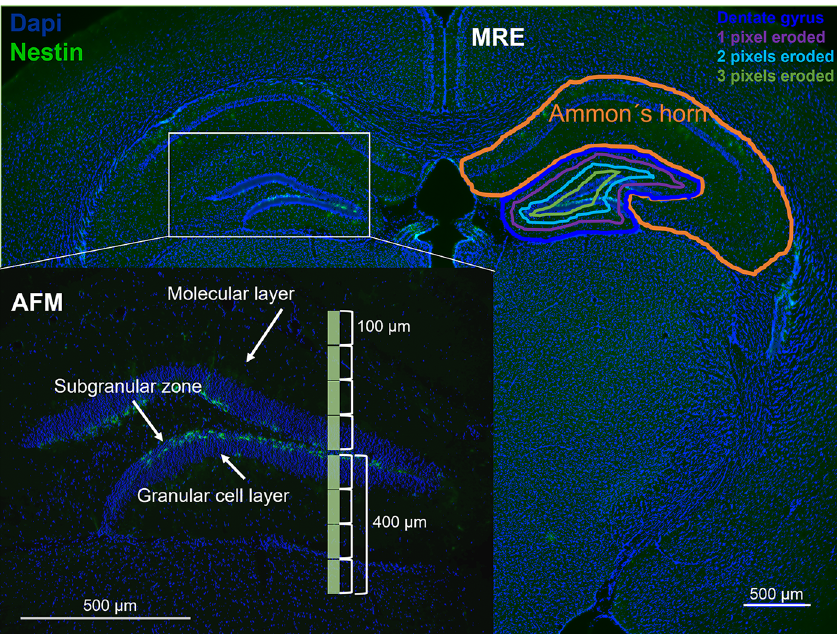
Figure 2. MRE masks and AFM measurement profiles. The MRE Ammon´s horn mask, dentate gyrus mask (DG), and DG mask eroded by 1, 2, and 3 pixels are schematically overlaid onto a histological image (magnification × 10). At the bottom, a schematic AFM measurement profile (in green) on the DG (magnification × 20). blue—DAPI (cell nuclei),